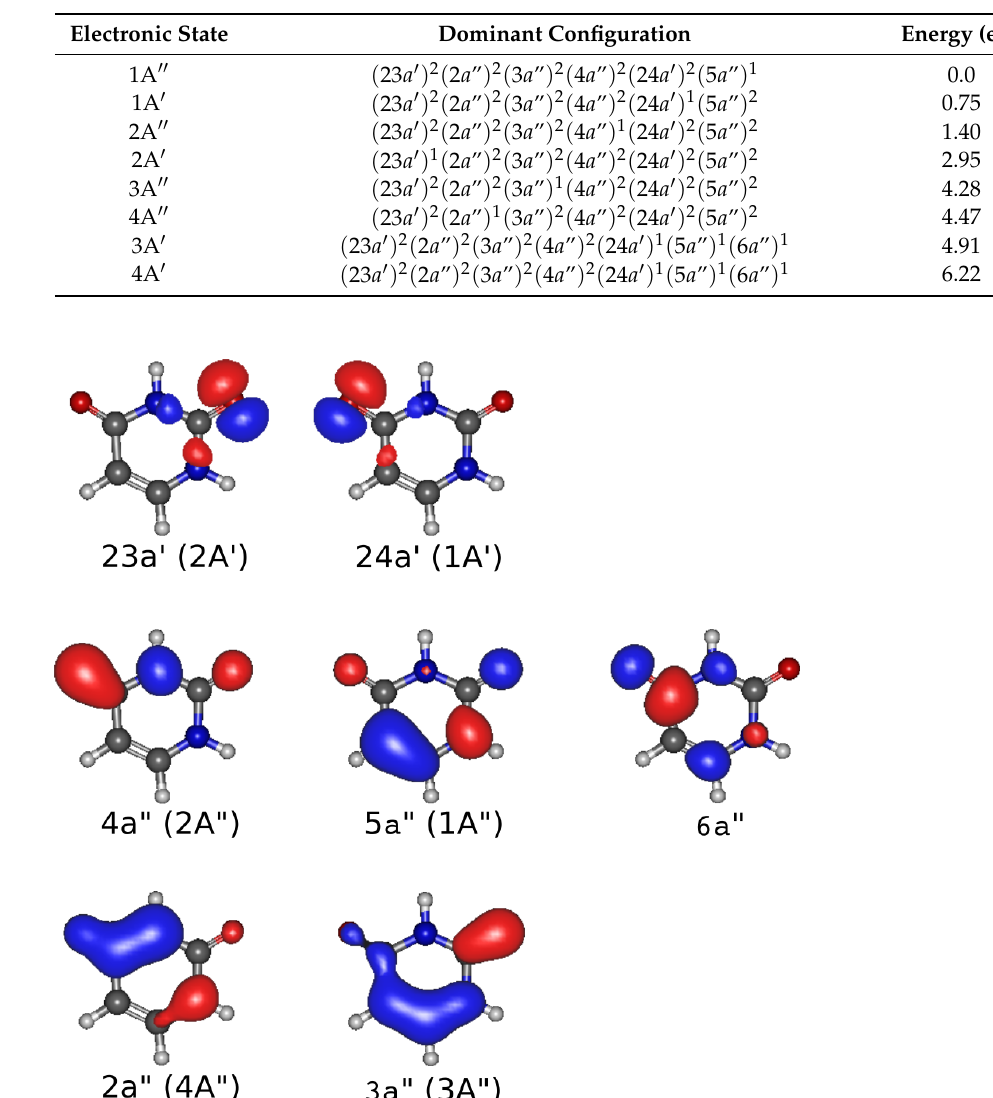
Table 1. Electronic states of U + with specification of the main electronic configuration (see molecular orbitals in Figure 5) and the electronic energies (in eV) referred to its ground state.